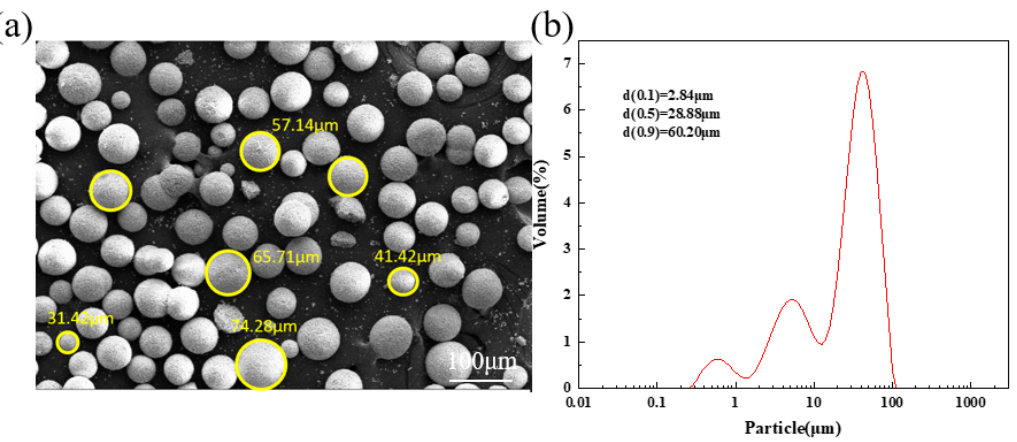
Figure 1. ( a ) Morphology of KNLN powders and ( b ) Size distribution of KNLN